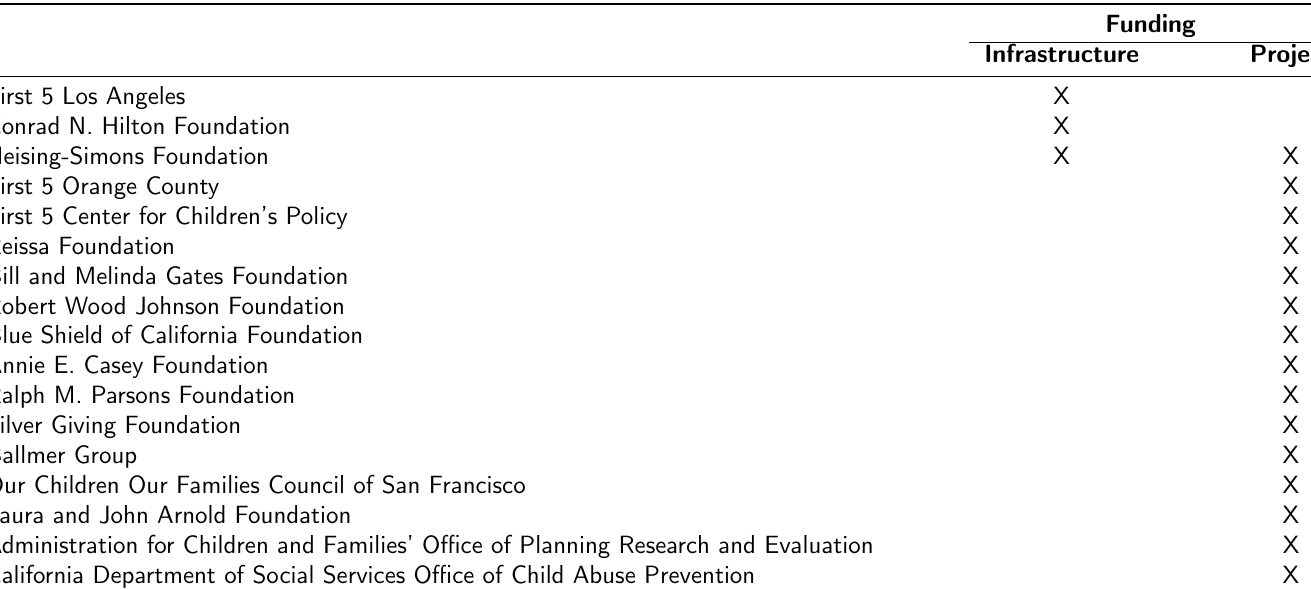
Table 1: Children’s Data Network funding partners, by type